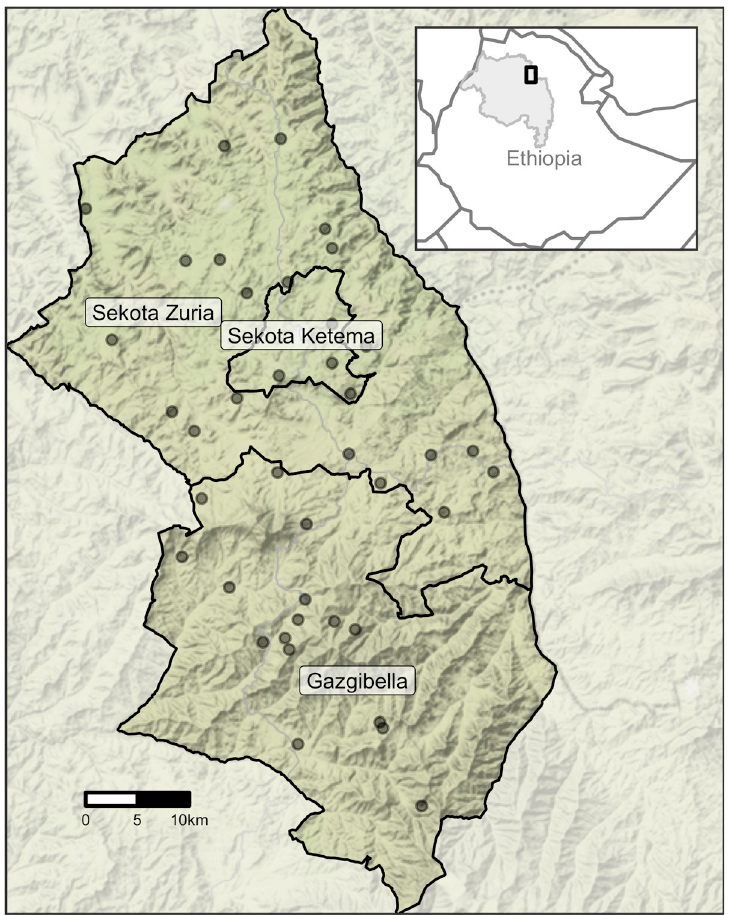
Fig 1. Map of study area. Inset (top right) highlights the Amhara Region (gray shading) of Ethiopia and the study area (black rectangle). Forty communities from three woredas (administrative level 3) in Amhara were included in the WUHA trial. The base map layer for this figure was downloaded from Stamen Maps (“Terrain”) and is available under the CC BY 3.0